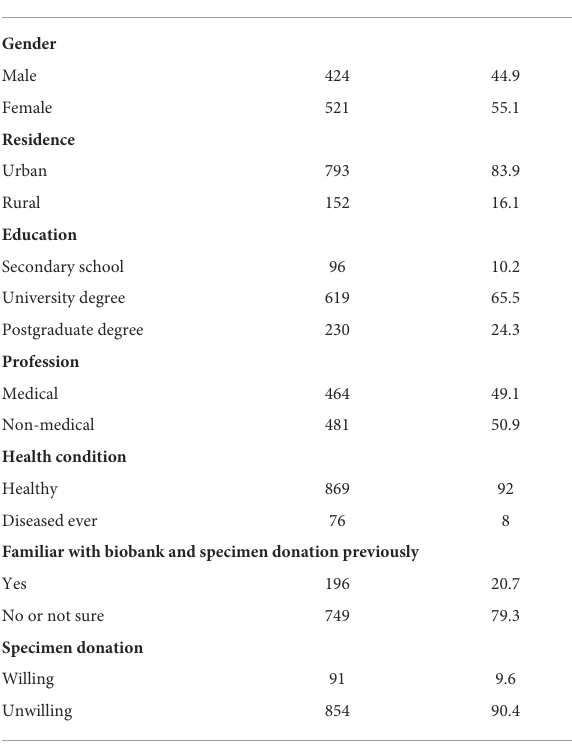
TABLE 1 Baseline characteristics of the participants.